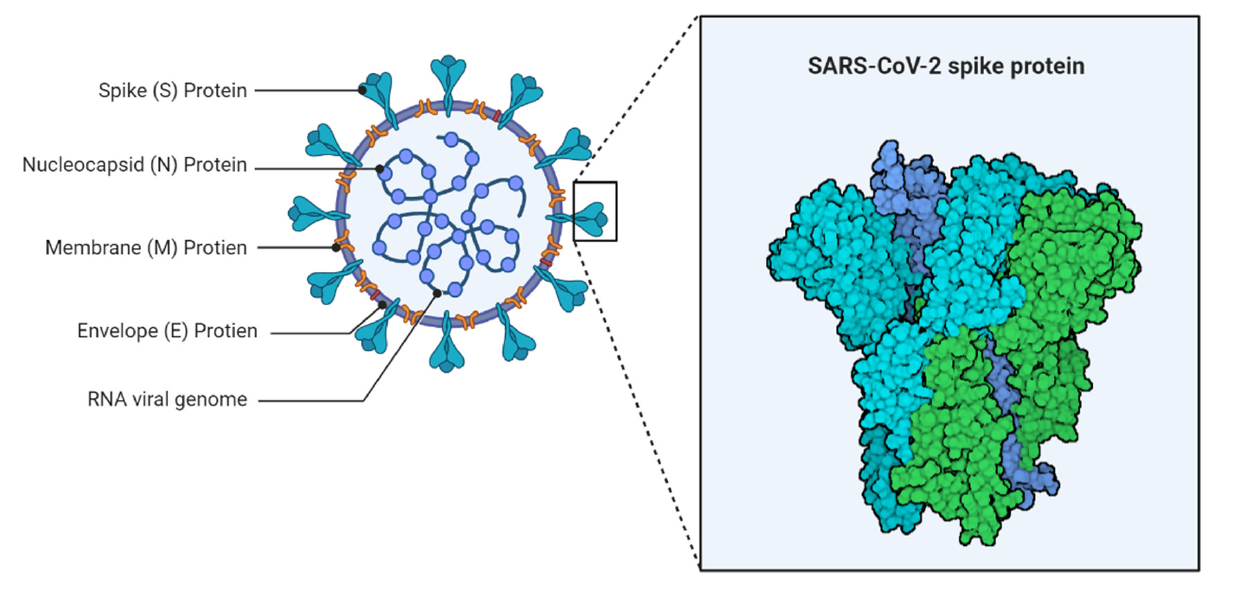
Figure 1. Structure of SARS-CoV-2.